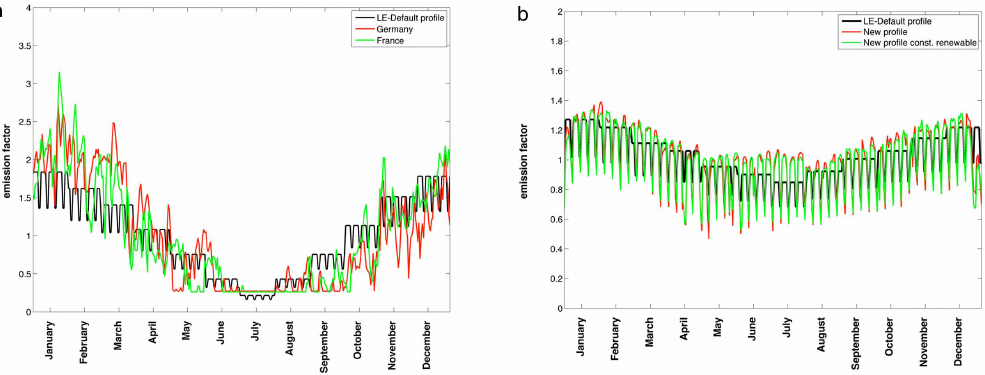
Fig. 4. Comparison between the new and the default seasonal (daily) emission factors for SNAP2 (a) retrieved from model grid cells located in Germany (longitude approximately 10 ◦ E, latitude approximately 52.5 ◦ N) and in France (longitude approximately 2.75 ◦ W, latitude approximately 43.75 ◦ N) and for SNAP1 (b) for